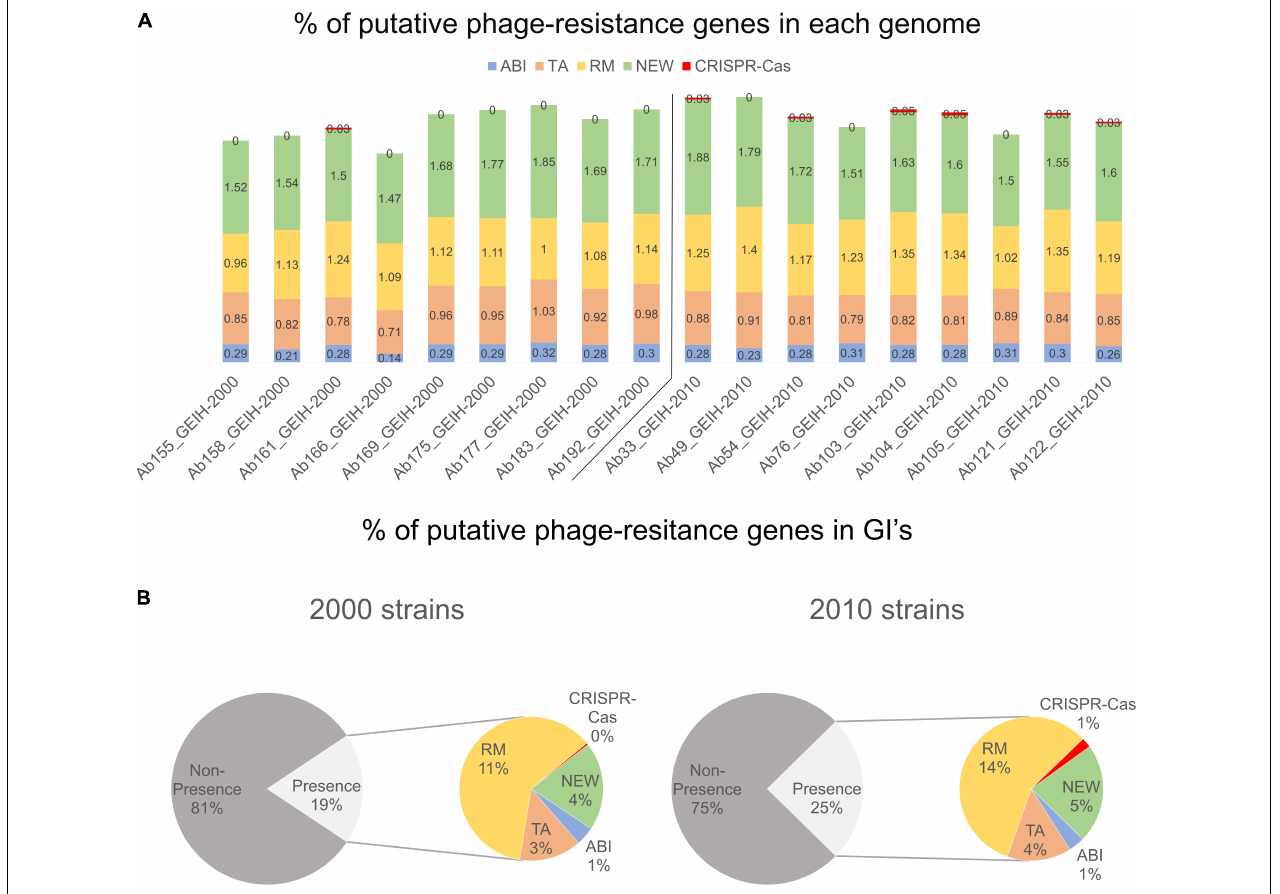
FIGURE 3 | (A) Frequency (%, rounded to two decimal numbers) of each group of genes in each genome with respect to total of genes: abortive infection (ABI) system, toxin/antitoxin (TA) system, restriction–modification (R–M) system, and genes associated with newly phage resistance bacterial mechanisms (NEW), e.g., Zorya, Hachiman, and Druantia. (B) Presence and non-presence of putative phage-resistant genes in GIs. Presence (%, rounded without decimal numbers) section is divided into different groups of